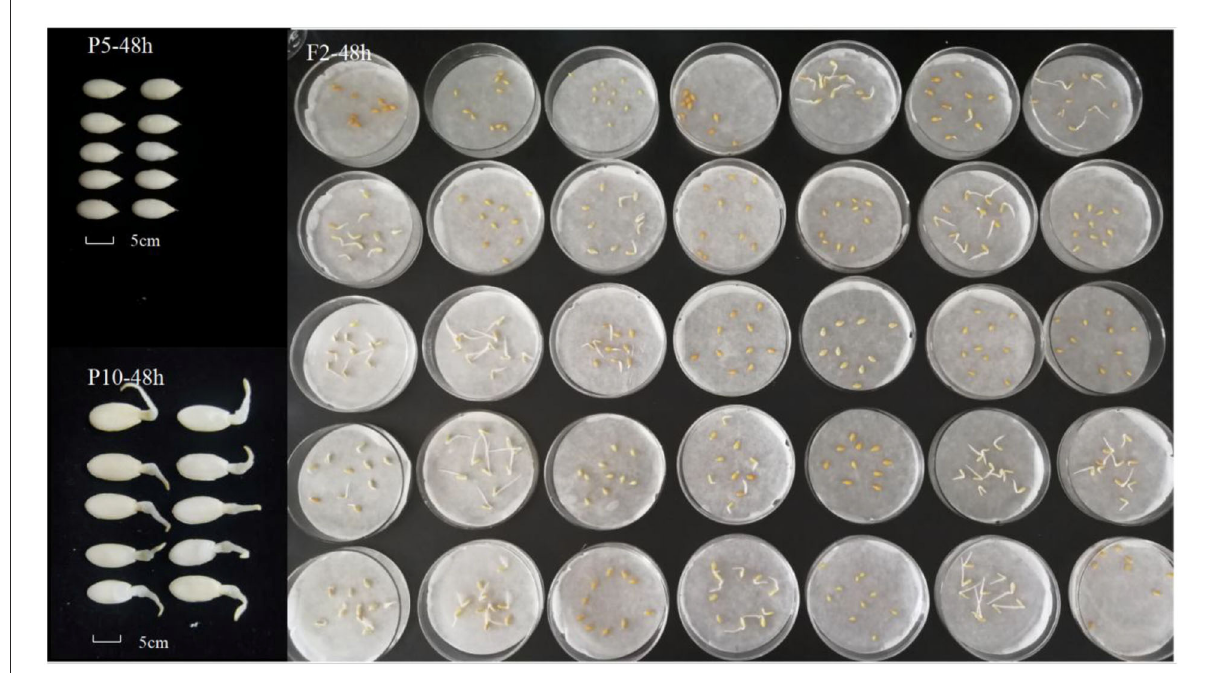
FIGURE2 Seed germination performance of two parents and their F 2 populations under the treatment with soaking time of 8h and germinate temperature of 28 ◦ C. Seeds from F 2 individuals fruit germination rate were investigated in 48h, and each culture dish contains one fruit seed.